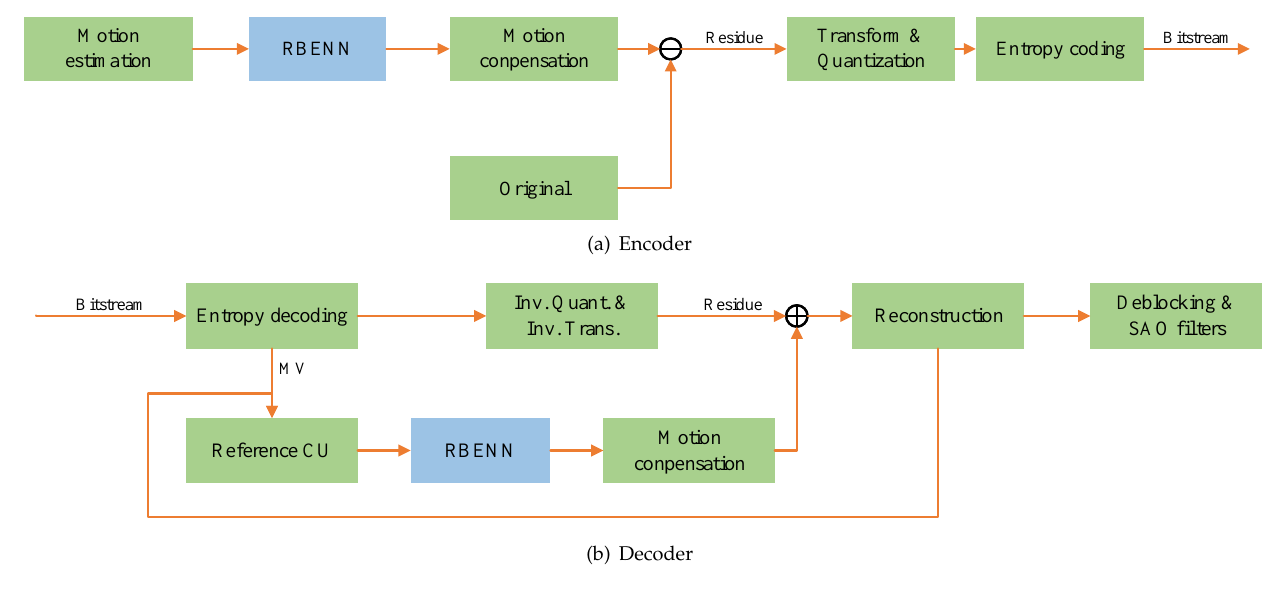
Figure 4. A diagram of RBENN integrated into